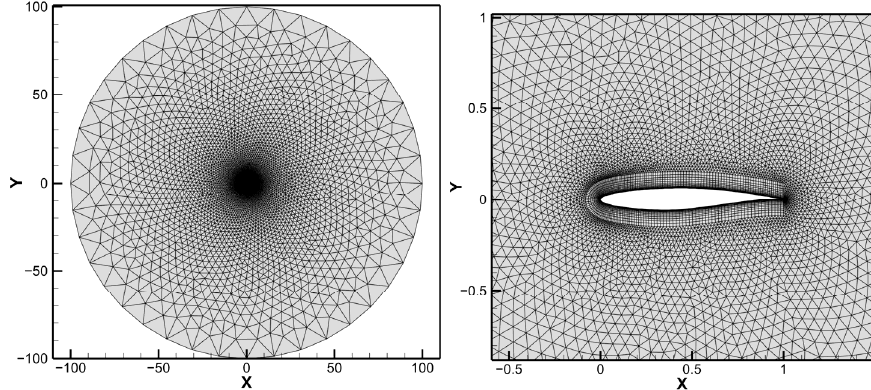
Figure 9. Computational mesh of RAE2822.